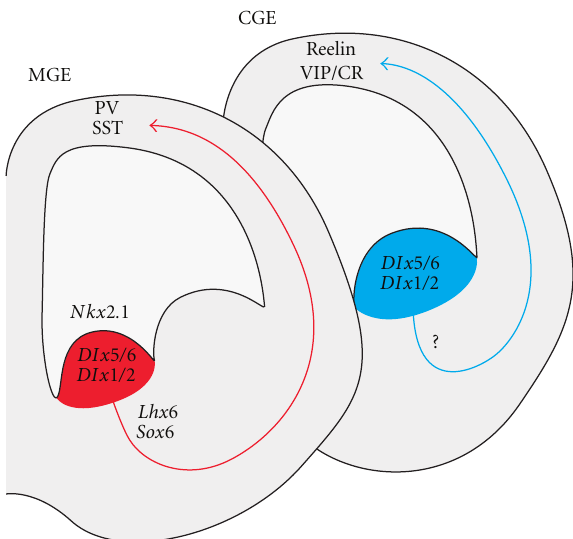
Figure 2: Genetic cascade governing cortical interneuron generation. Corticolimbic interneurons originate in the medial and caudal ganglionic eminences (MGE and CGE). The homeobox transcription factors Dlx5/6 , Dlx1/2 and the proneural gene Mash1 (not shown) are expressed throughout the ganglionic eminences and are required for the generation of all GABAergic interneurons. The MGE generates parvalbumin-positive (PV) basket cells and chandelier cells, as well as somatostatin-positive (SST) cells (including Martinotti cells). These rely on the sequential expression of Nkx2.1 , Lhx6 , and Sox6 for proper specification and maturation (see text). The genetic cascade governing the specification of CGE-derived interneurons has not been fully elucidated yet, but Nkx6.2 and Gsh2 are expressed in the CGE and might be important players (see